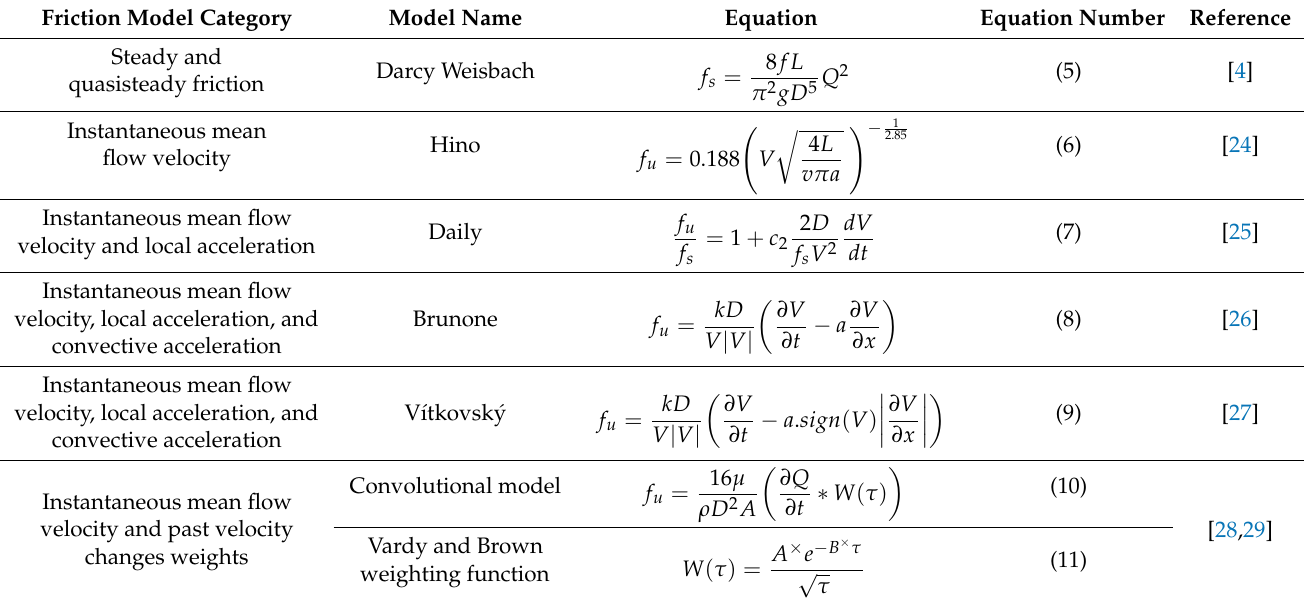
Table 2. Unsteady friction models’ categories and